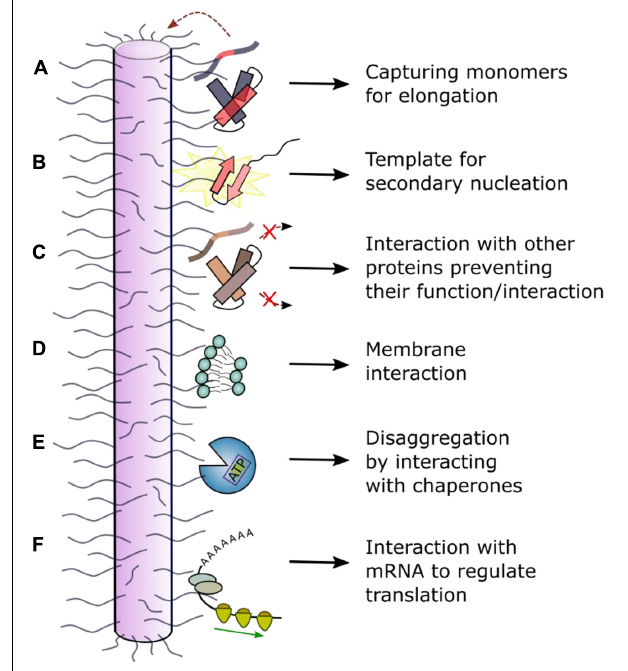
FIGURE 5 | Schematic of interactions between the dynamically disordered regions of fibrils and other molecules. Dynamically disordered regions displayed on the surface of ordered amyloid fibrils can play roles in their function and cellular dysfunction. (A) The fibril “fuzzy coat” could capture amyloid precursors and facilitate their self-assembly into amyloid by (B) secondary nucleation or other molecular events. (C) Interaction with other (non-)amyloidogenic proteins could inhibit or alter their function. (D) Interaction with membranes can result in a toxic mechanism involving membrane disruption. (E) Interaction with chaperones can result in fibril depolymerization. (F) Interaction with RNA has been observed in a functional context for the protein CPEB (cytoplasmic polyadenylation element binding) which regulates long-term memory (Khan et al., 2015; Hervas et al., 2020). In other cases, disruption of cellular RNA could enhance phase separation and lead to cellular toxicity and/or